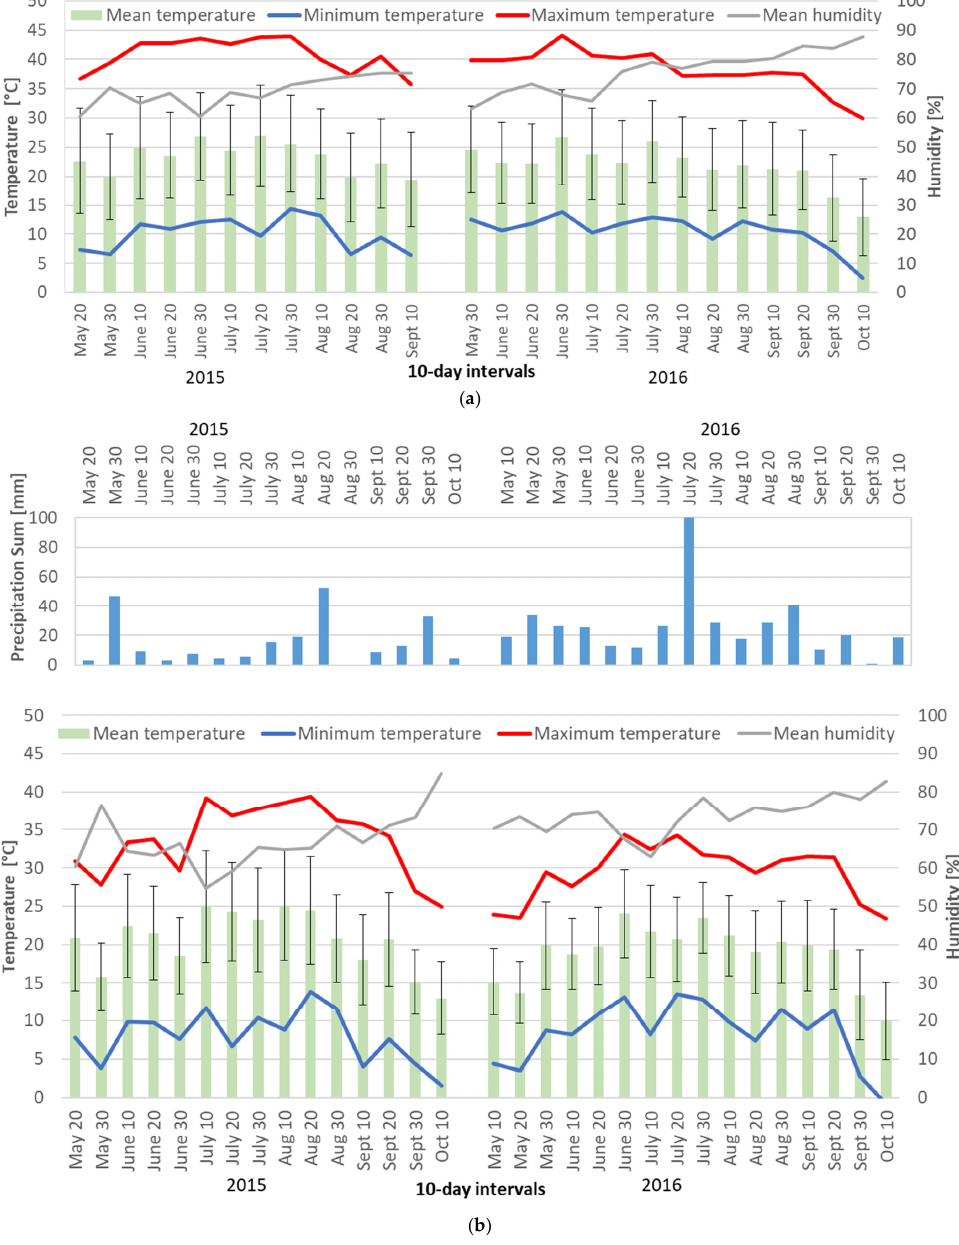
Figure 1. ( a ) Polytunnel and ( b ) open-field temperature (mean ± sd) (°C) and relative humidity (%) dataset of tomato PGR experiment conducted in 2015 and in 2016, presented from the date of the planting time to the end of the season, grouped in decades. Precipitation was measured only in the open